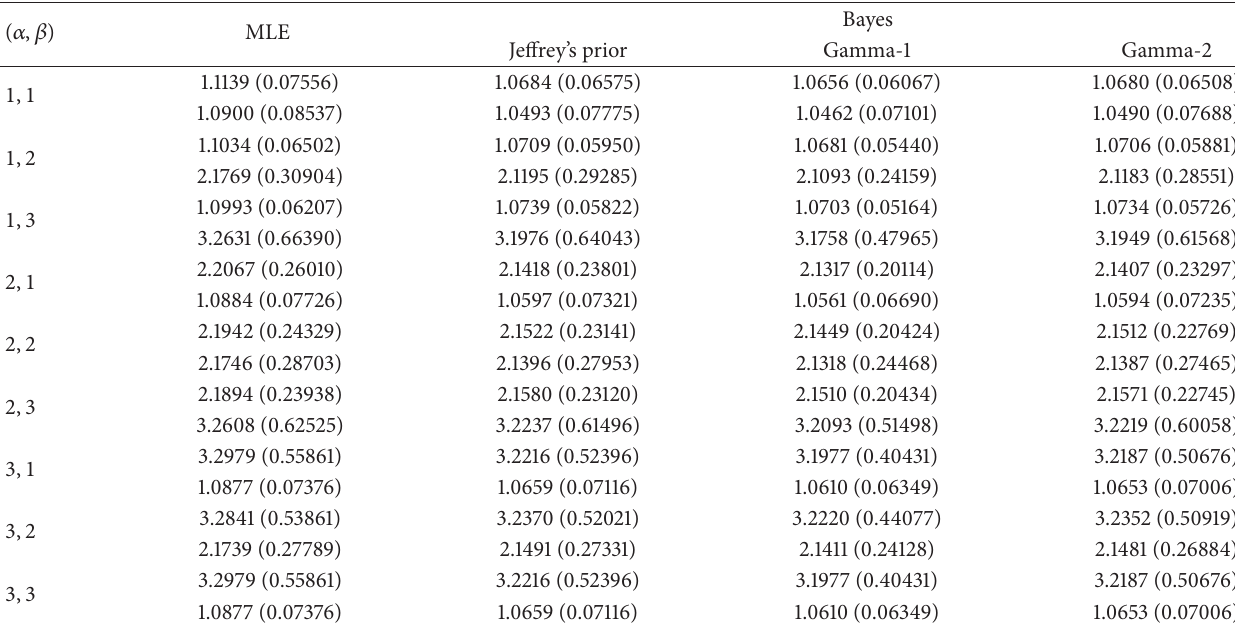
Table 2: Average estimates and MSEs (in the brackets) of the estimators of 𝛼 (in the first row of each cell) and 𝛽 (in the second row of each cell) for complete sample 𝑛 = 20 with varying parameters.